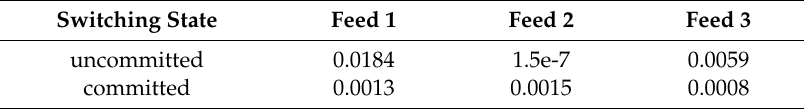
Figure 13. Feeder node voltage in mode 2: ( a ) SOP is uncommitted to operation; ( b ) Soft open point is committed to operation. Table 2. Standard deviation of the feeder node